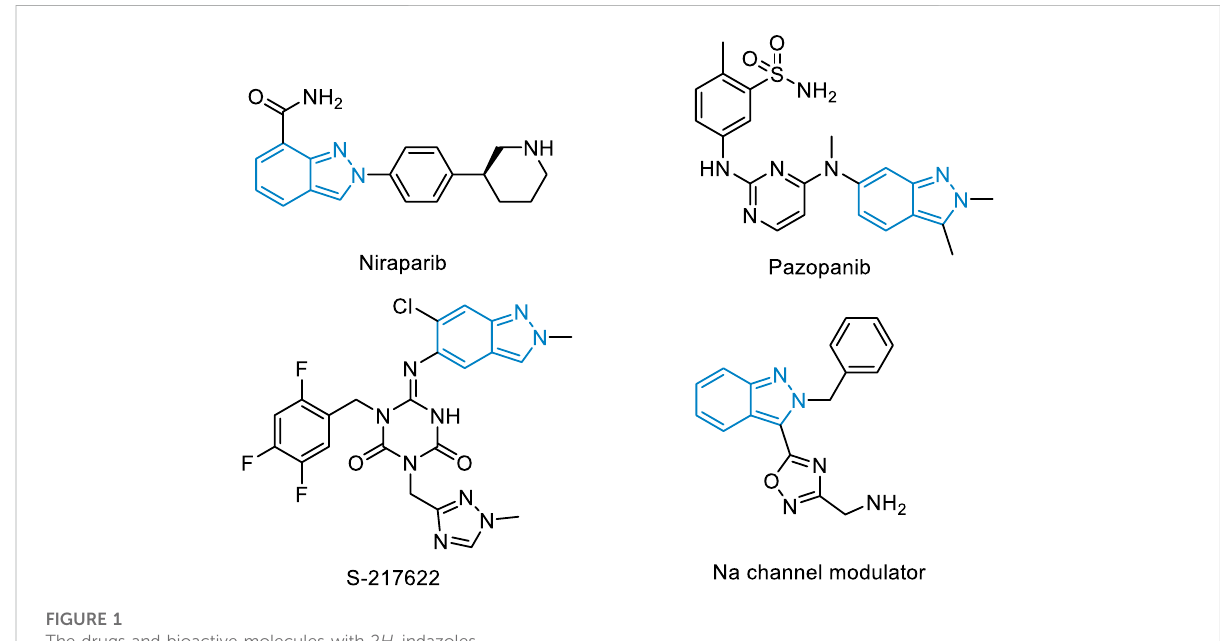
FIGURE 1 The drugs and bioactive molecules with 2 H